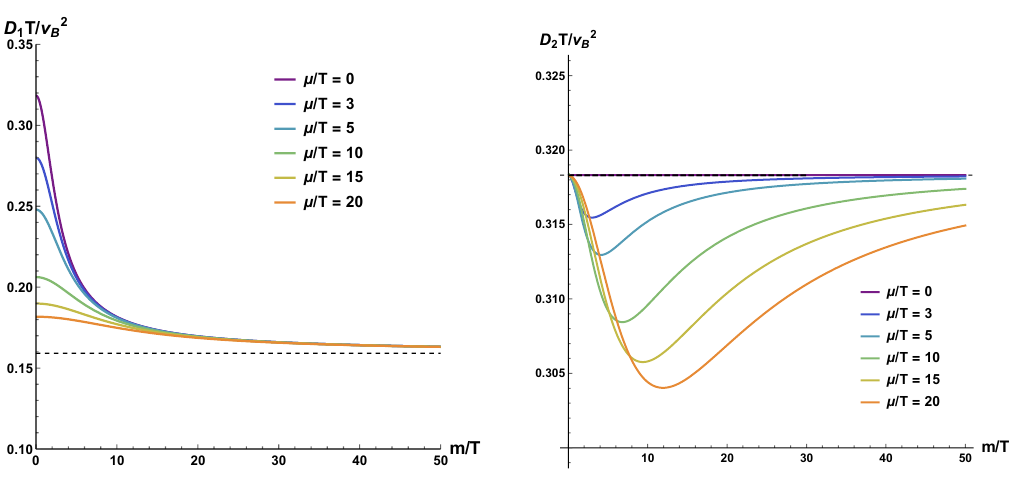
Figure 5: The longitudinal diffusion constants at finite charge. D reduces to pure crystal diffusion at µ = 0, while D at µ = 0. The dashed lines indicate the AdS diffusion), 1 /π (charge